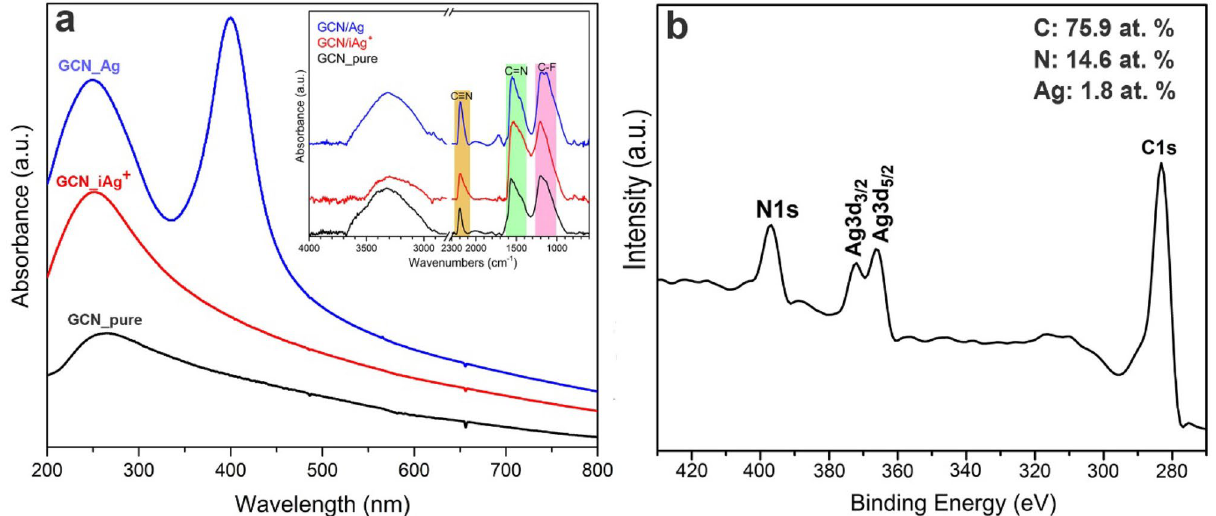
Figure 2. ( a ) UV–Vis absorption spectra of pure GCN (black line), GCN with immobilized ionic silver (red line), and GCN with immobilized AgNPs (blue line); the corresponding FT-IR spectra are shown in the inset of panel ( a ). ( b ) XPS survey spectrum of the GCN/Ag nanohybrid showing atomic content of the